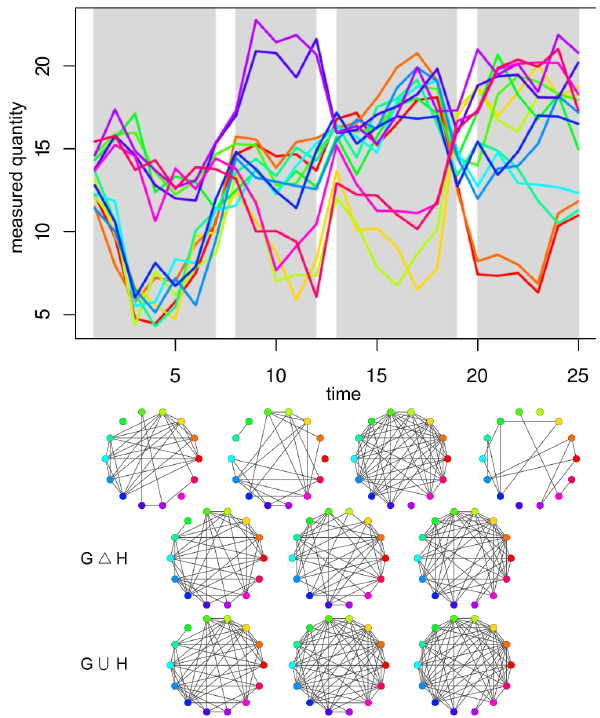
Figure 1. Illustration of the MULTSEG problem. (Upper panel) 14 time series over 25 time points; (Middle panel) Networks reconstructed from the shown series. The networks correspond to the 4 optimal time series segments, depicted with light grey rectangles in the upper panel. The color coding of nodes correspond to the colors of the time series; (Lower panel, the last two rows) Symmetric difference and union networks from the consecutive segments resulting in the optimal value of 2.40 for the objective D , with relative density as a distance